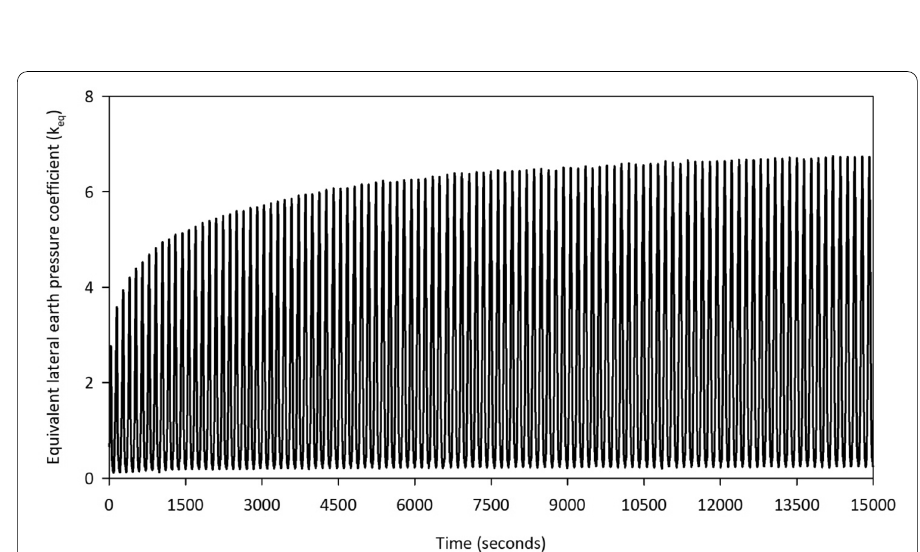
Fig. 13 Variation of the equivalent lateral earth pressure coefficient (K) between cycles 1 and 120 (Test